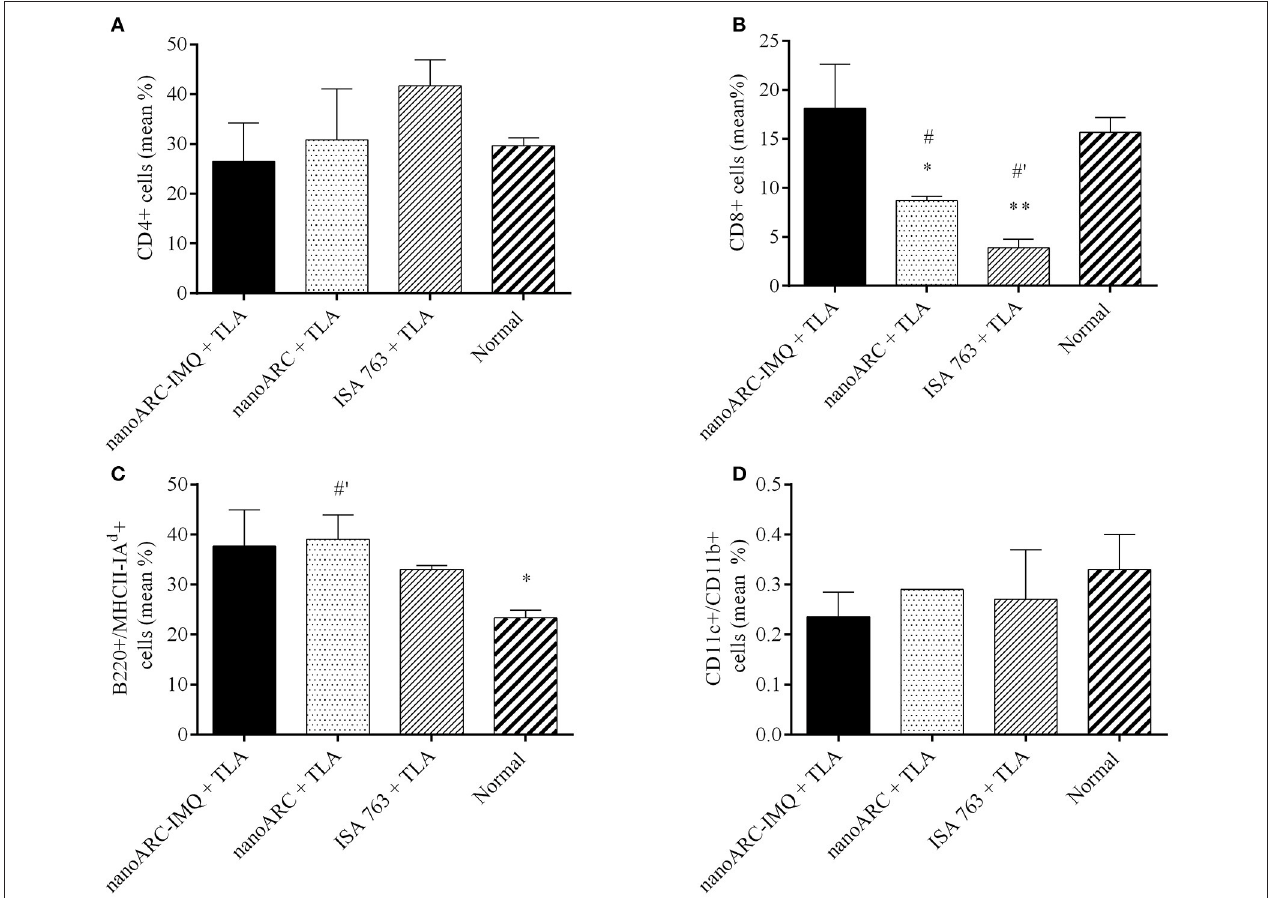
FIGURE 8 | Surface cell markers. Non-stimulated splenocytes from nanoARC-IMQ + TLA, nanoARC + TLA and ISA + TLA vaccinated mice were used to assess the phenotypical expression of cell markers. (A) CD4T Lymphocytes. (B) CD8T Lymphocytes. (C) Activated B Lymphocytes (B220 + /MHCII(I-A d ) + ). (D) CD CD11c + /CD11b + . The graphic shows the percentage average of positive cells for each marker. Asterisks indicate significant differences between nanoARC-IMQ + TLA and the remainder groups. Numerals indicate significant differences between non-immunized and the reminder groups ( # p < 0.05; # ′ p < 0.01).